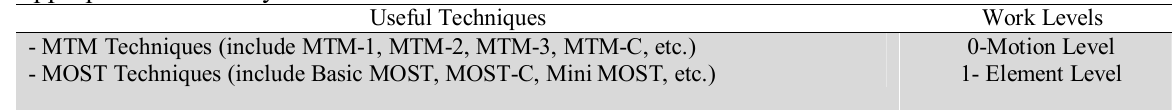
Appropriate time study methods based on orders of work units Useful Techniques Work